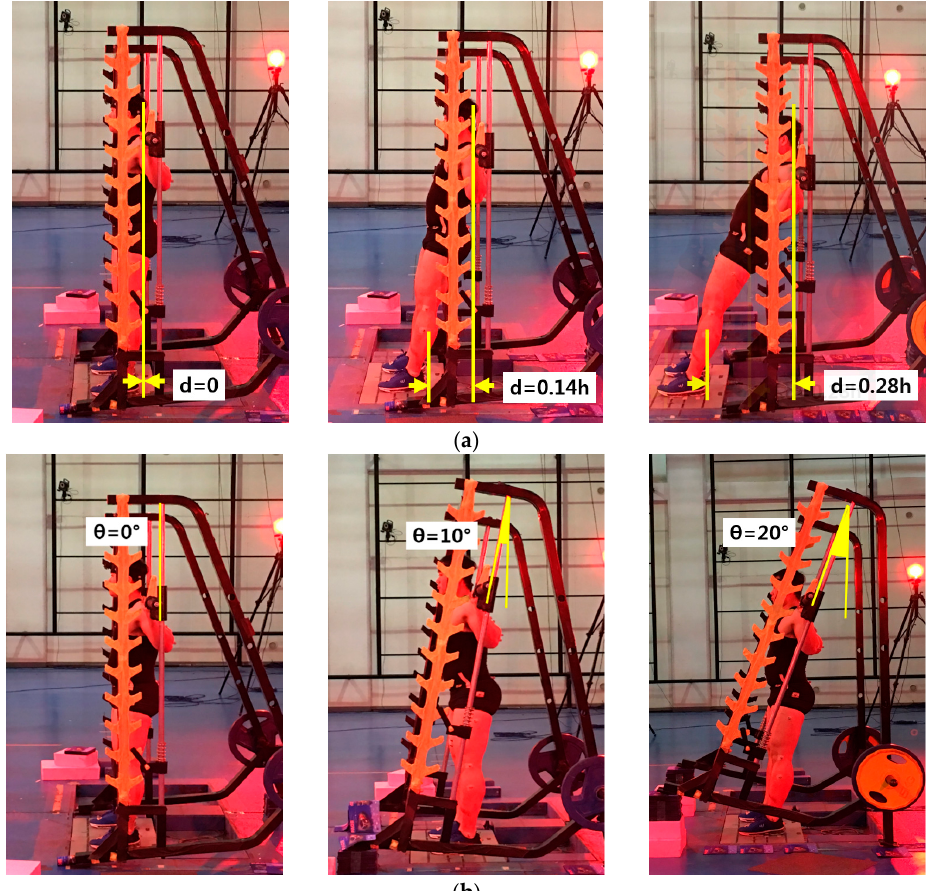
Figure 1. Independent variables of experiment: ( a ) foot position and ( b ) angle of barbell bar guides.